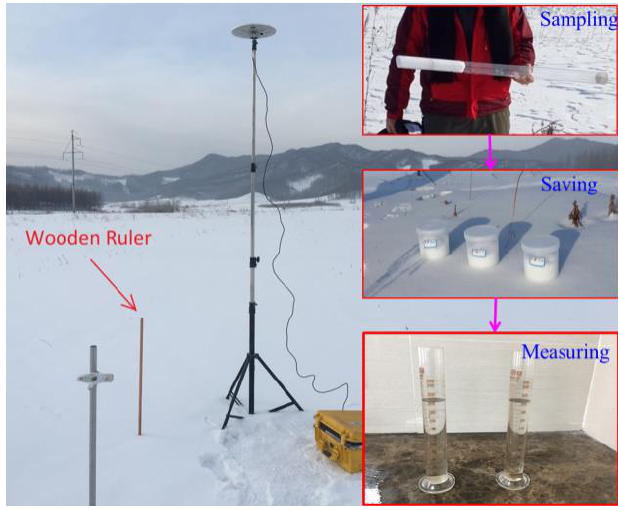
Figure 9. The experimental campaign conducted in Harbin, China.